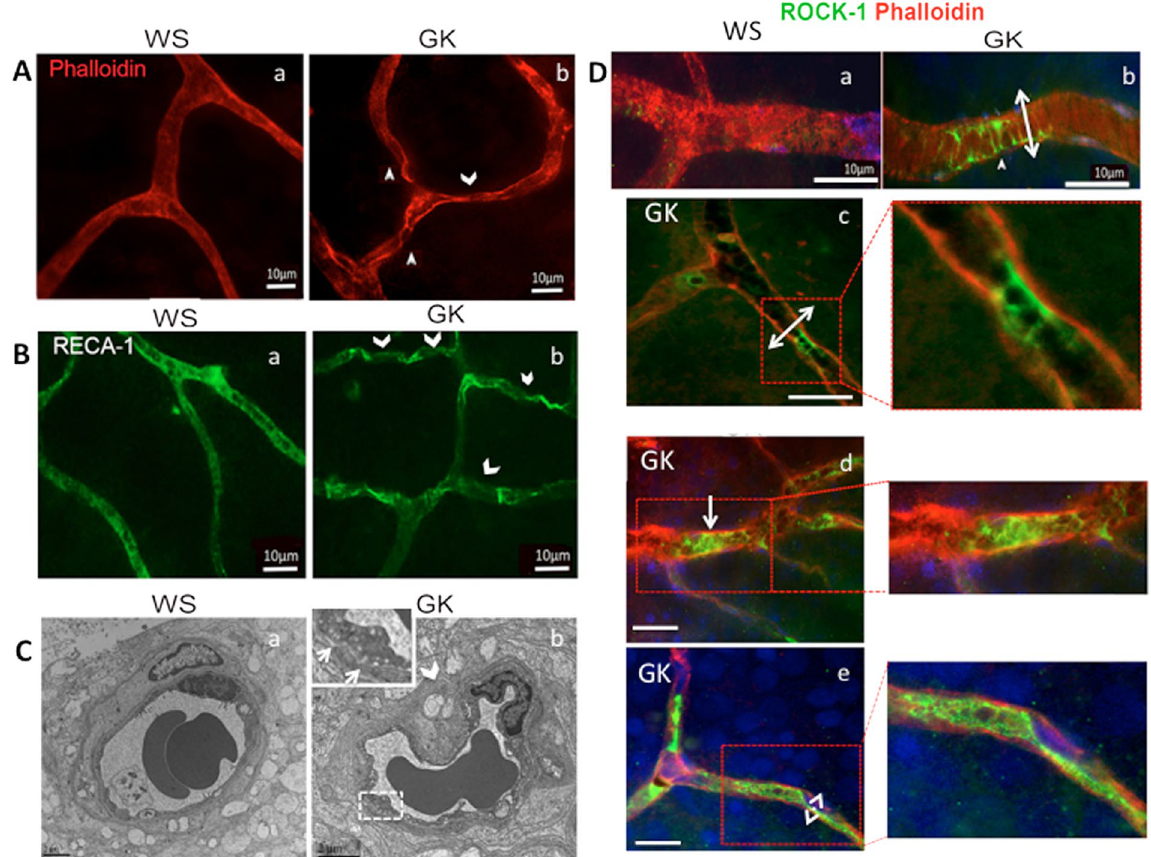
Figure 1. ROCK-1 activation in micro vessels of diabetic retina ( A ). Phalloidin-stained actin on flat-mounted retina vessels of 12 months-old rats. a - WS control rat, b - GK rat showing focal vasoconstrictions (arrowheads). ( B) RECA-1 stained endothelial cells on flat-mounted retina vessels of 12 months-old rats. a-WS control rats, b - GK rats showing irregular labeling (arrowheads). ( C ) Transmission electron microscopy (TEM) showing micro vascular constriction (arrowhead) and vacuoles in endothelial cells (inset) but preserved nuclei in GK rat retinal vessels as compared to normal WS structure. ( D ) ROCK1-phalloidin double staining (ROCK-1 in green, phalloidin in red and DAPI in blue) a – b : on flat-mounted retina, ROCK-1 is faintly expressed in WS rat vessels but is located in constricted area where smooth muscle cells are contracted (b, double arrow). c – e : on GK retina sections, focal ROCK-1 expression is located in the endoluminal side of constricted vessel (c and magnification), in aggregated luminal cells (d and magnification) and at the membrane of endothelial cells where the vascular lumen is diminished (e, double arrow and magnification). Scale bar = 10 µ m, for TEM scale bar = 3 µ